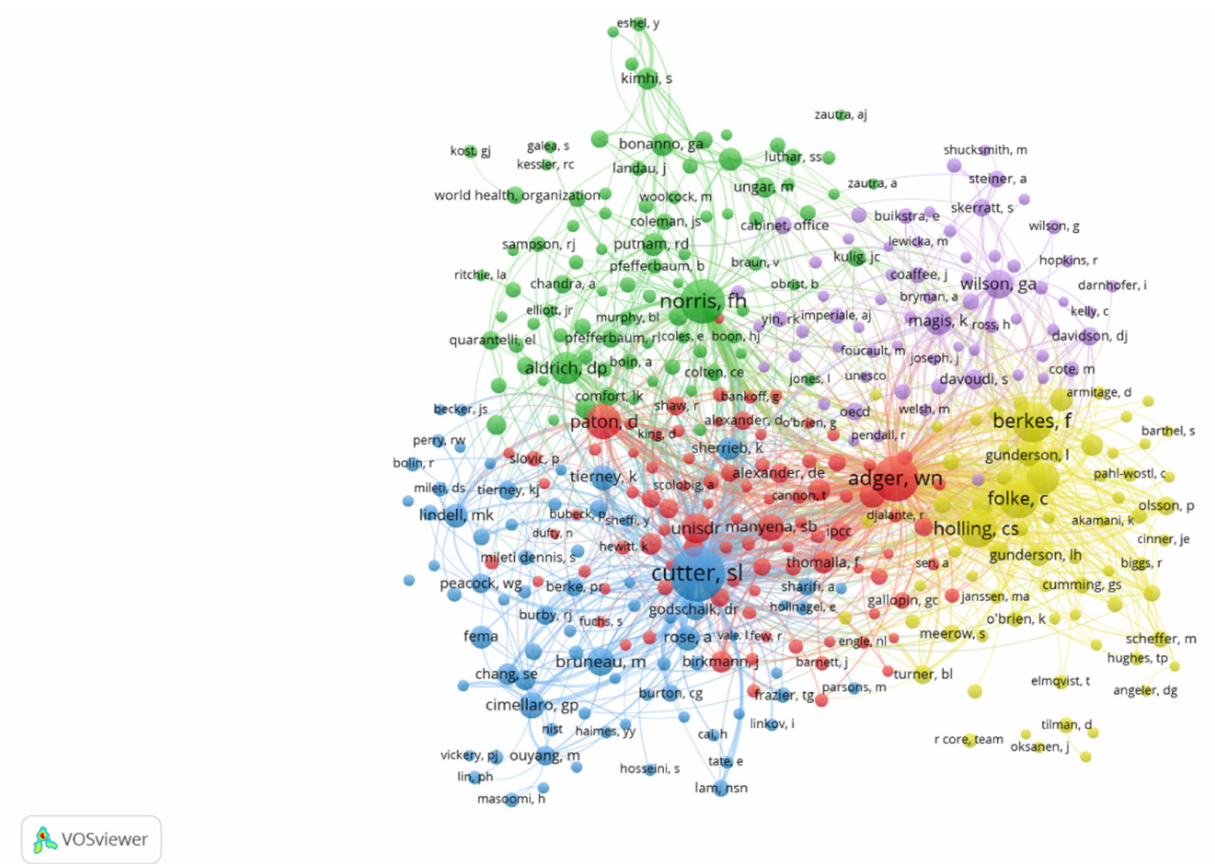
Figure 9. Network visualization map of co-cited authors in community resilience field from 2001 to 2020. Note that the size of the node represents the author’s citation frequency and the thickness of lines between two nodes refers to the co-citation